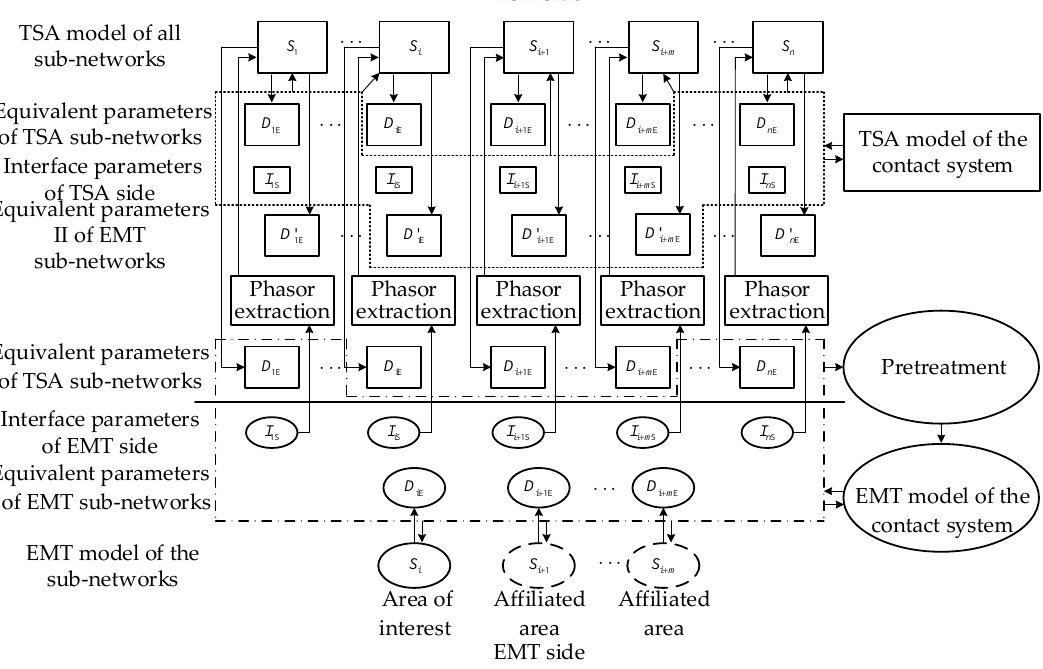
Figure 2. Information exchange diagram of a hybrid real-time simulation of a variable area of interest.